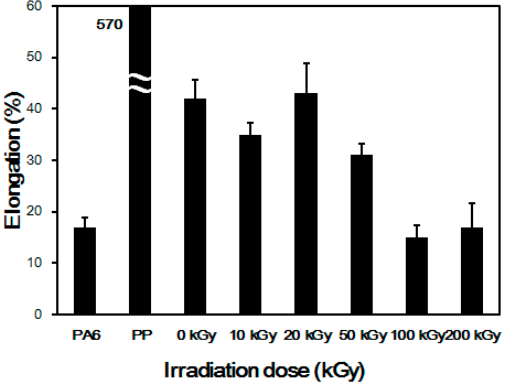
Figure 7. Effect of irradiation dose on the elongation at break of PA6/PP (80/20) blends.